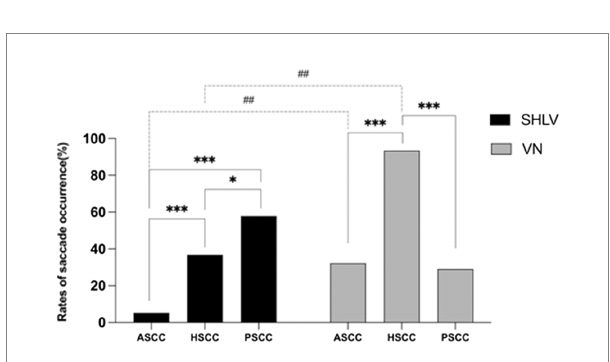
FIGURE 2 Comparison between the incidences of saccade occurrence in anterior semicircular canal (ASCC), horizontal semicircular canal (HSCC) and posterior semicircular canal (PSCC) on the affected sides in SHLV patients and VN patients. * p < 0.05, *** p < 0.001, ## p < 0.01. Dotted line: comparison between SHLV and VN group. Solid line: comparison between three semicircular canals within SHLV or VN group.